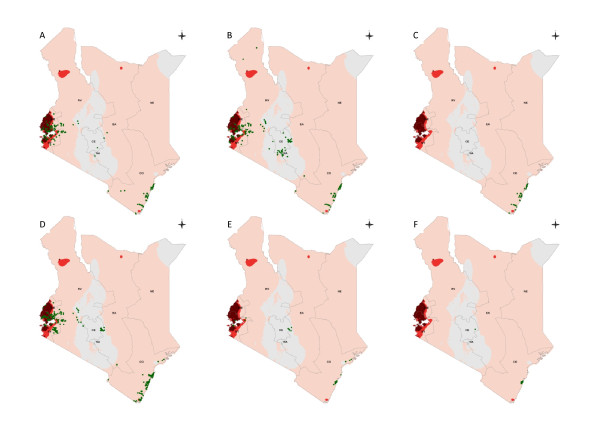
a-f. Map of Kenya showing the distribution of spatially unique survey sites for a) Anopheles gambiae b) Anopheles arabiensis, c) Anopheles merus, d) Anopheles funestus, e) Anopheles pharoensis, f) Anopheles nili, displayed over the first-level administrative units (provinces) and predicted PfPR2-10 endemicity classes: PfPR2-10 > = 40%; PfPR2-10 5-39%; PfPR2-10 0.1% < 5%; PfPR2-10 < 0.1% [21]as shown in Figure legend.